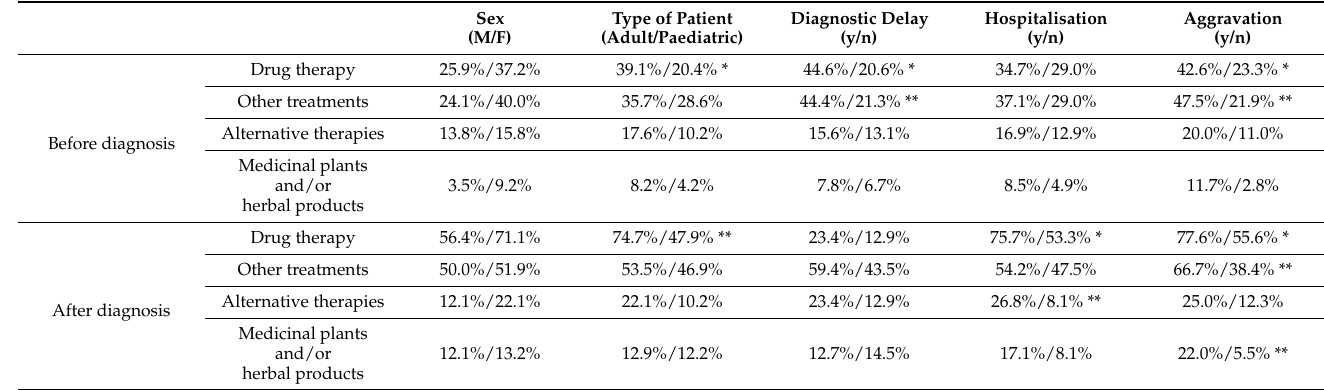
Table 2. Treatments used before and after diagnosis.